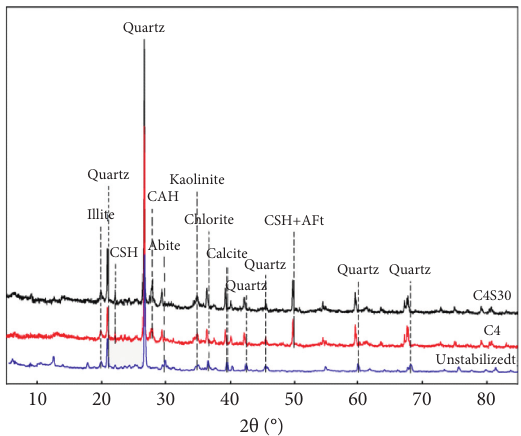
Figure 10: XRD diffractograms of cemented soil with different